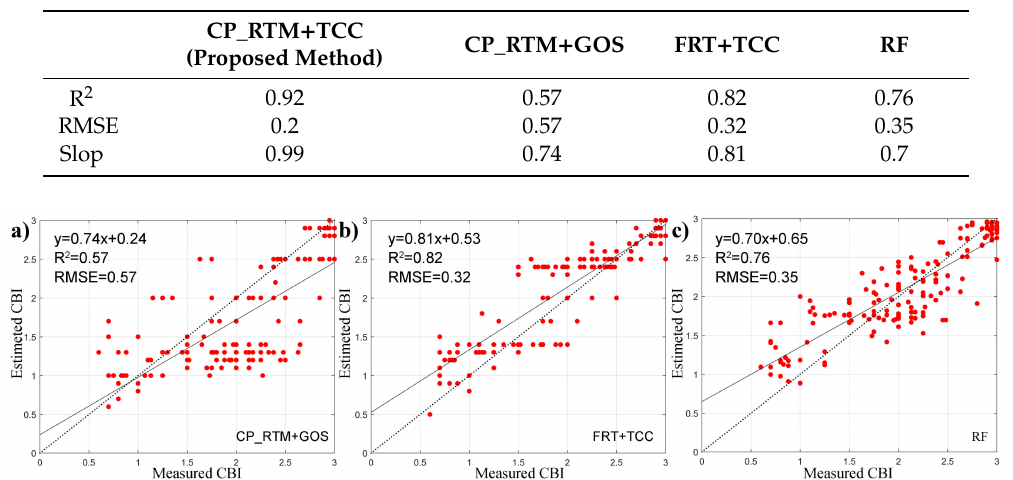
Table 4. The accuracy summary of the four methods used in this study. The method proposed in this study is CP_RTM + TCC, which has the highest accuracy of burn severity estimation.